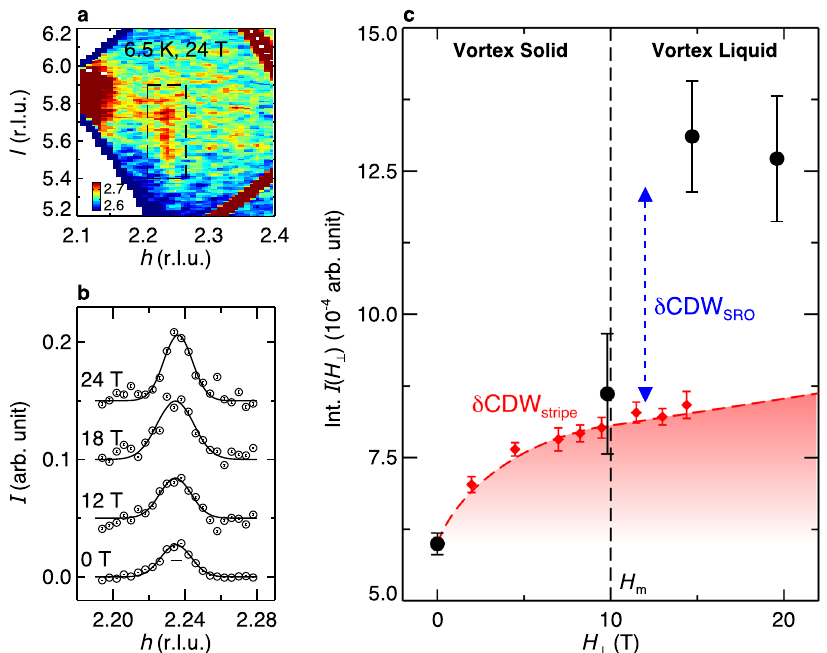
Fig. 3 | Magnetic- fi eld dependence of CDW in LSCO. a CDW intensity map mea- sured at 6.5 K, 24 T, projected onto hl plane. b Magnetic- fi eld-dependent h -cuts through the CDW peak. Solid lines are one-Gaussian fi ts to the data. A linear backgroundhasbeensubtracted,anddataareshiftedforclarity.Thehorizontalbar represents instrumental resolution. c Integrated CDW intensities as a function of magnetic fi eld. Note here the magnetic- fi eld projection perpendicular to the CuO 2